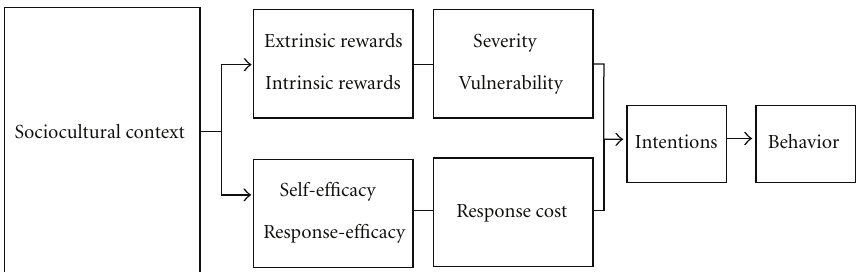
Figure 1: Protection Motivation Theory